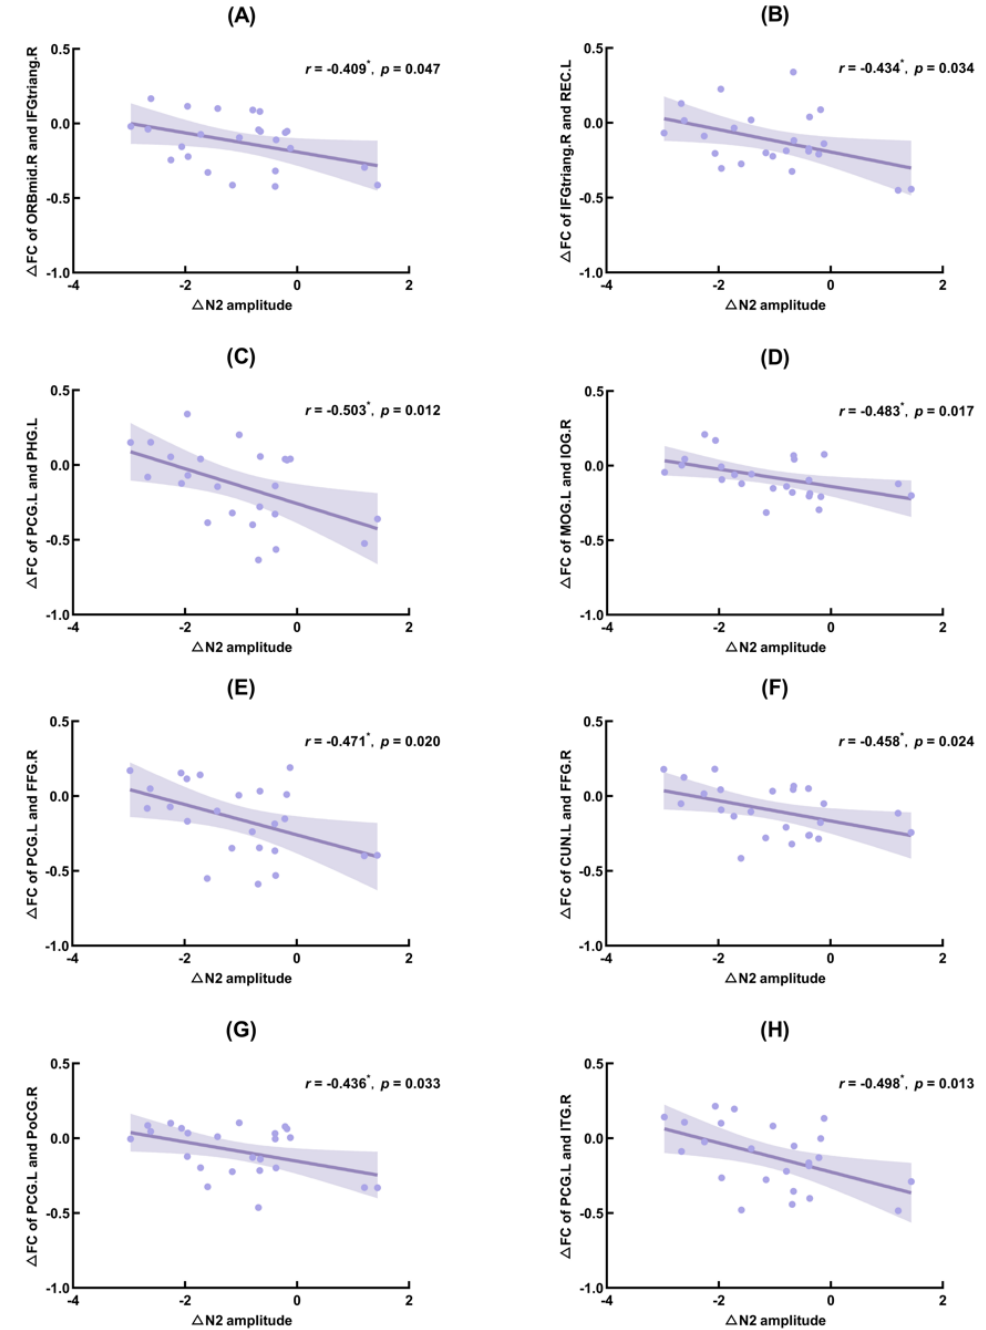
Figure 7. Significant correlation between functional connectivity (FC) changes and N2 amplitude changes. ORBmid.R: right orbital middle frontal gyrus; IFGtriang.R: right triangle inferior frontal gyrus; REC.L: left gyrus rectus; PCG.L: left posterior cingulate gyrus; PHG.L: left parahippocampal gyrus; MOG.L: left middle occipital gyrus; IOG.R: right inferior occipital gyrus; FFG.R: right fusiform gyrus; CUN.L: left cuneus; PoCG.R: right postcentral gyrus; ITG.R: right inferior temporal gyrus. ( A ): Correlation between ∆ FC of ORBmid.R and IFGtriang.R and ∆N2 amplitude ; ( B ): Correlation between ∆ FC of IFGtriang.R and REC.L and ∆N2 amplitude ; ( C ): Correlation between ∆ FC of PCG.L and PHG.L and ∆N2 amplitude ; ( D ): Correlation between ∆ FC of MOG.L and IOG.R and ∆N2 amplitude ; ( E ): Correlation between ∆ FC of PCG.L and FFG.R and ∆N2 amplitude ; ( F ): Correlation between ∆ FC of CUN.L and FFG.R and ∆N2 amplitude ; ( G ): Correlation between ∆ FC of PCG.L and PoCG.R and ∆N2 amplitude ; ( H ): Correlation between ∆ FC of PCG.L and ITG.R and ∆N2 amplitude . *: p < 0.05.